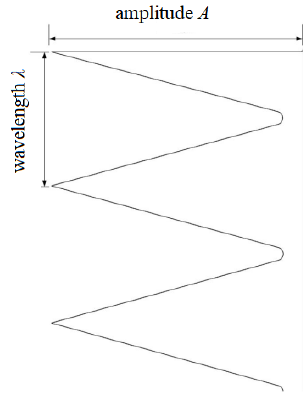
Figure 6. The geometric parameters of leading-edge serrations.